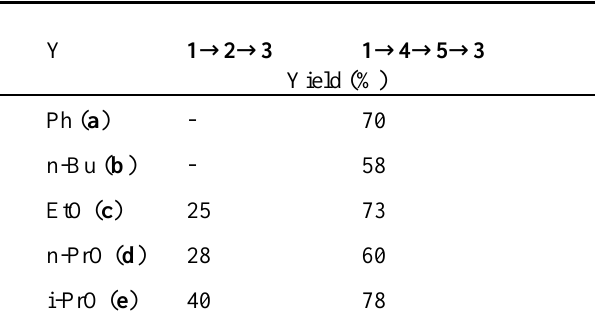
Table 1. Yields of hexahydrophosphinine oxides 3a - e by the two methods (Scheme